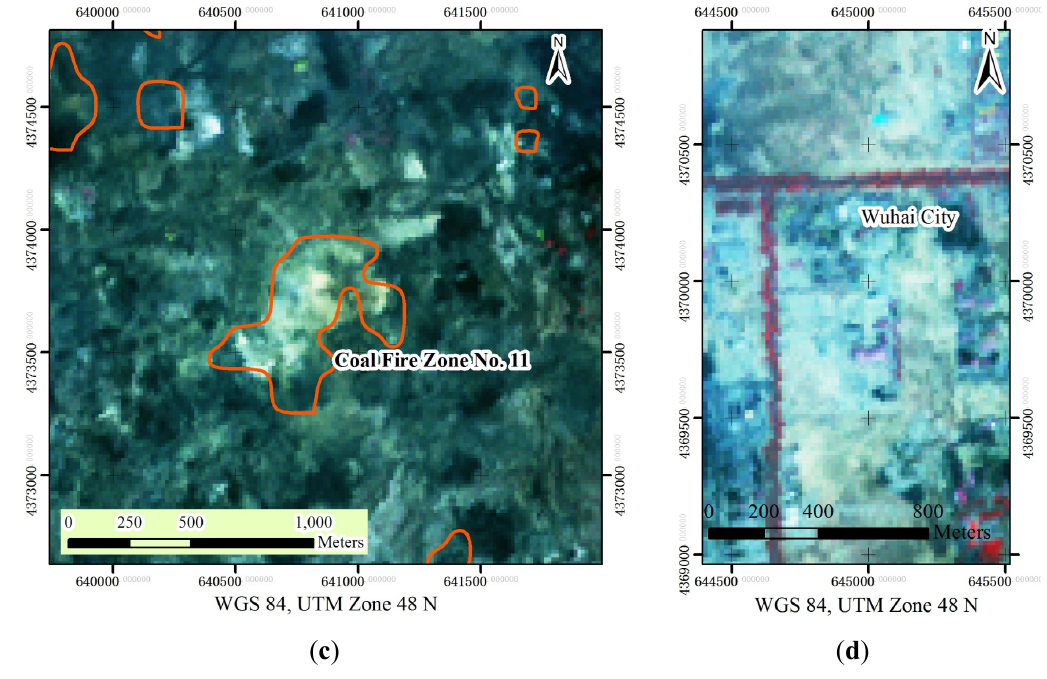
Figure 12. Ground and orbital views of areas affected by fire in the Wuda field: ( a ) excavation area for fire extinguishing in Coal Fire Zone No. 11; ( b ) excavated coal fire area in Coal Fire Zone No. 11; ( c ) Coal Fire Zone No. 11 (center polygon), overlaid to a high-reflectance area, as shown by ASTER VNIR; ( d ) similarities in spectral responses between a coal fire extinguishing area and a residential area in Wuhai